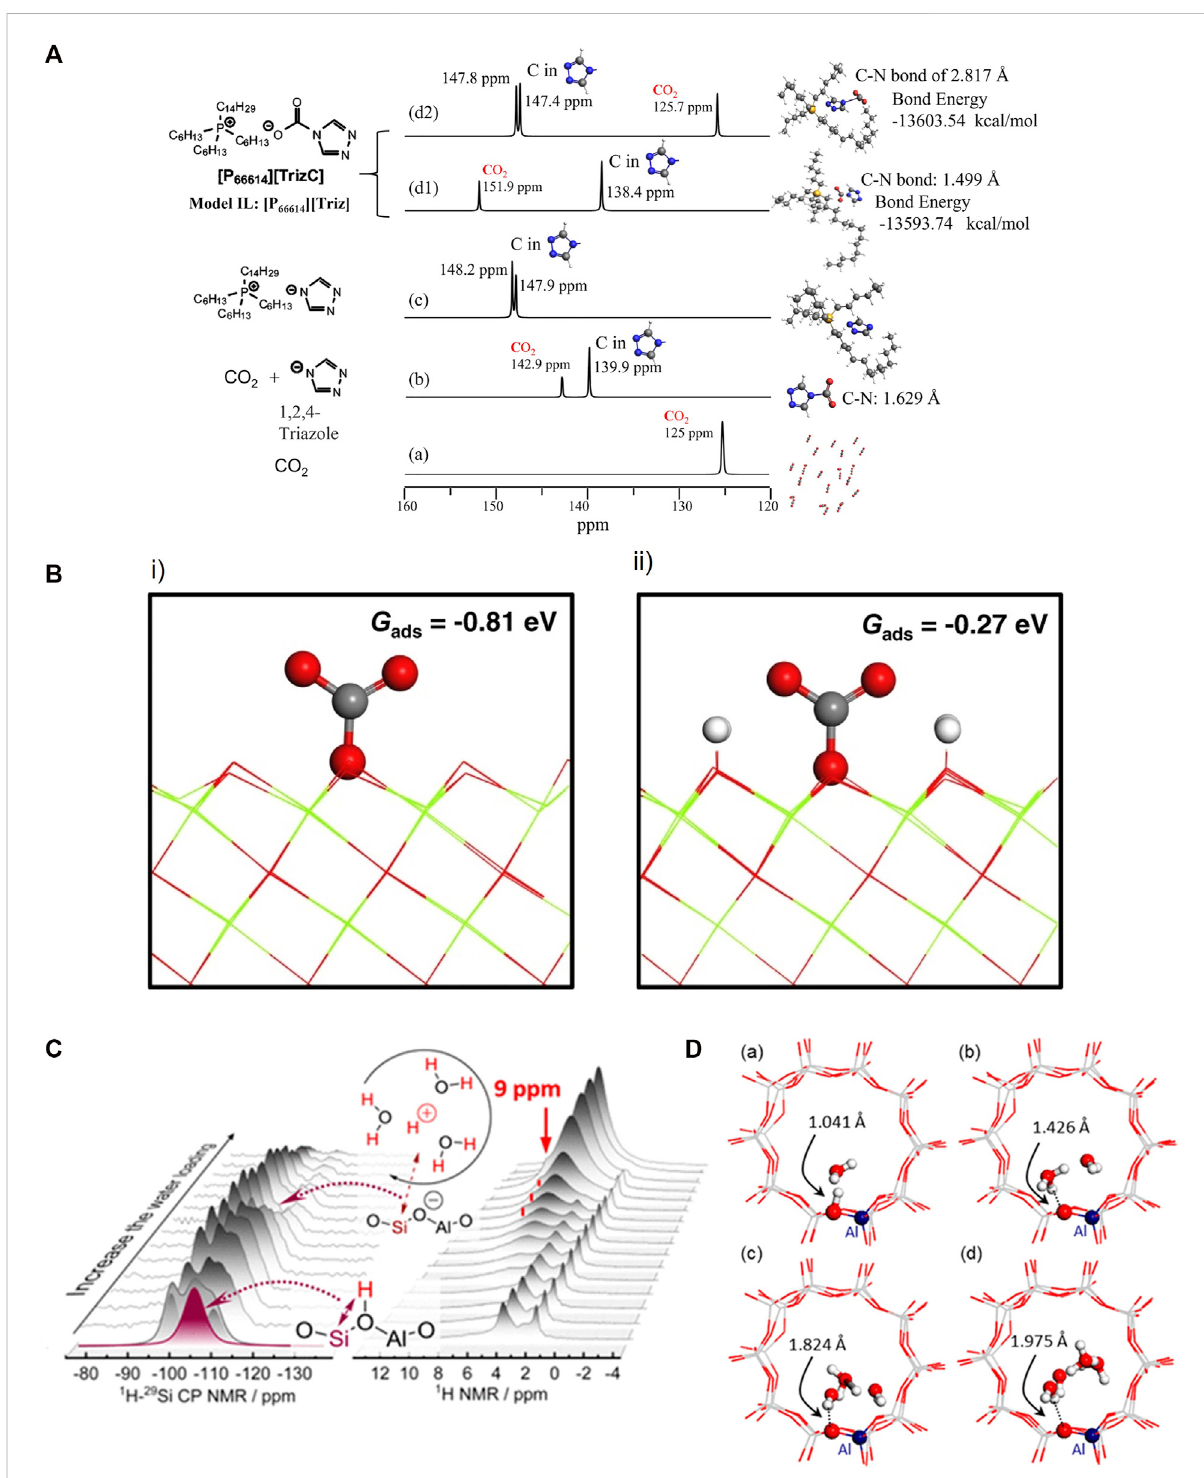
FIGURE 4 (A) DFT-NMR predicted 13 C NMR spectra of CO 2 and triazole in various cases of model ionic liquids [P 66614 ][Triz]. (a) Pure CO 2 gas; (b) CO 2 molecule interacts with a triazole anion. (c) The two carbons associated with trizole in [P 66614 ][Triz]; (d) When a CO 2 molecule is absorbed onto IL of [P 66614 ][Triz],therearetwopossibilitiesofabsorptionswithoneformingastrongC-Nbondingof1.499 Å(d1)andtheotheroneformingalooseC-N bond of 2.817 Å (d2). (B) Molecular CO 2 adsorption on modeled (i) MgO (111) and (ii) MgO(111)-4H. Reprinted from open access from ref